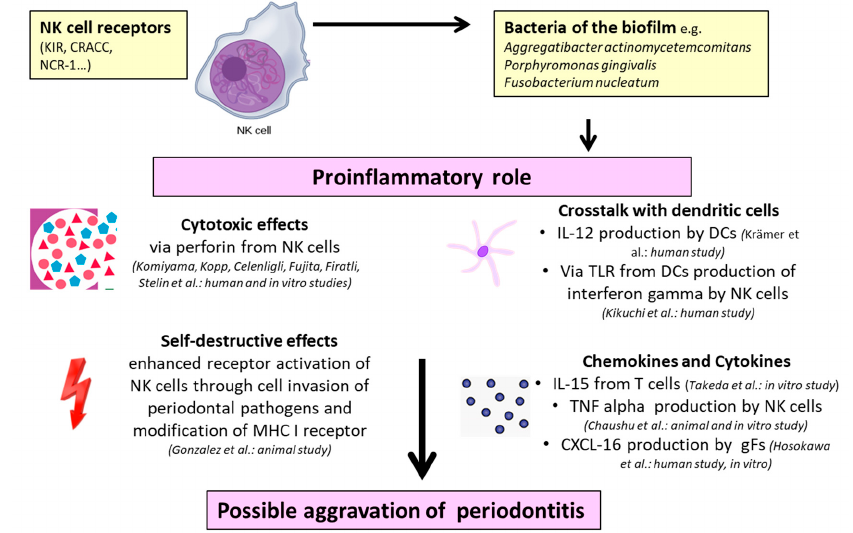
Figure 3. Proinflammatory properties of NK cells in periodontitis: The references and experimental study model are given in parentheses (human, animal, and in vitro). NK cell—natural killer cell; DC—dendritic cell; gF—gingival fibroblast; KIR—killer cell immunoglobulin-like receptor; CRACC—CD2-like receptor-activating cytotoxic cell; NCR-1—natural cytotoxicity triggering receptor 1; IL—interleukin; TLR—Toll-like receptor; MHC—major histocompatibility complex; TNF- α —tumor necrosis factor alpha; and CXCL—CXC-motif ligand chemokine.